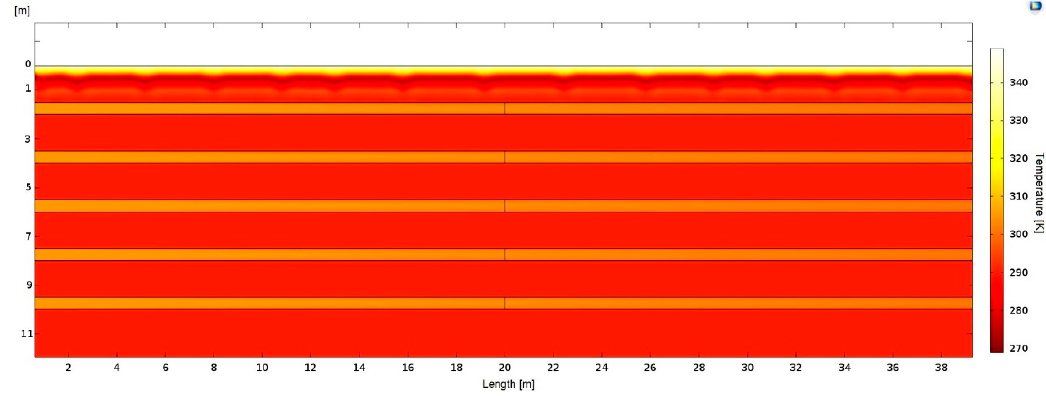
Figure 2. Thermal penetration depth generated by the earth surface temperature.